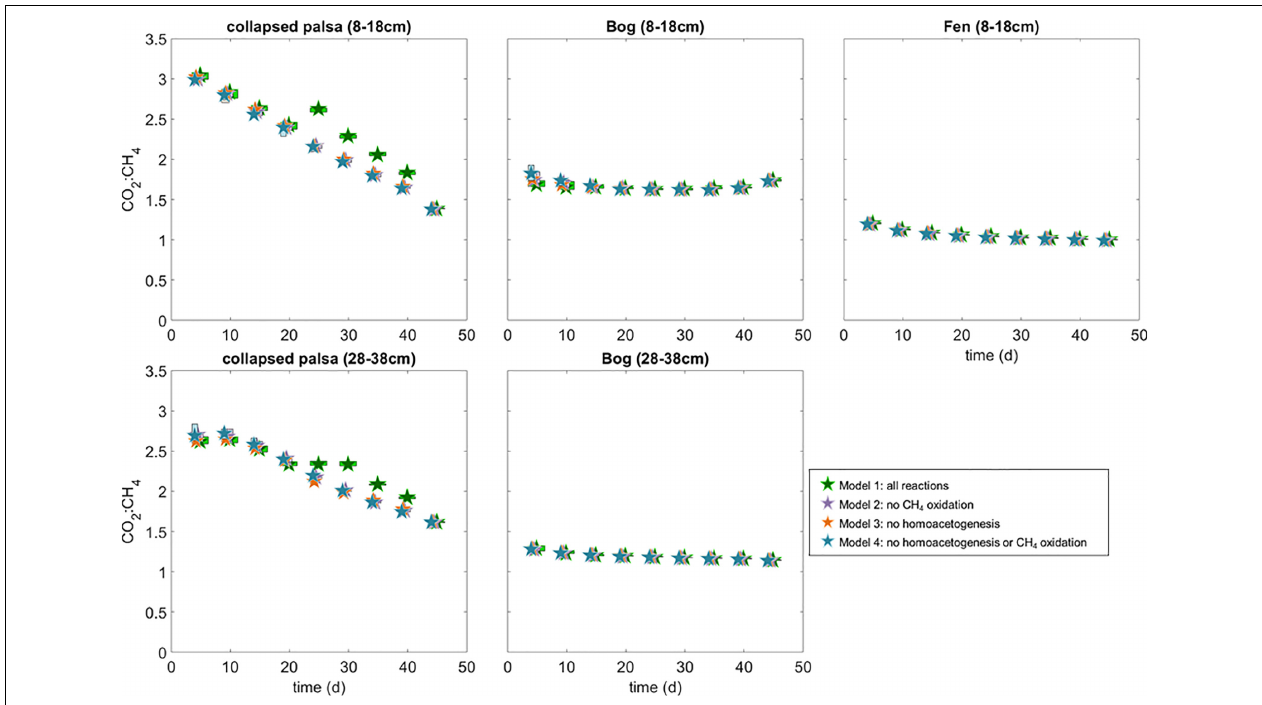
FIGURE 8 | Ratio of modeled rates of CO 2 and CH 4 production for each of the incubations and model variants. Box widths are staggered as in Figures 5 , 6 , but interquartile ranges of the CO 2 :CH 4 are tightly constrained and often smaller than the size of the median symbols at this